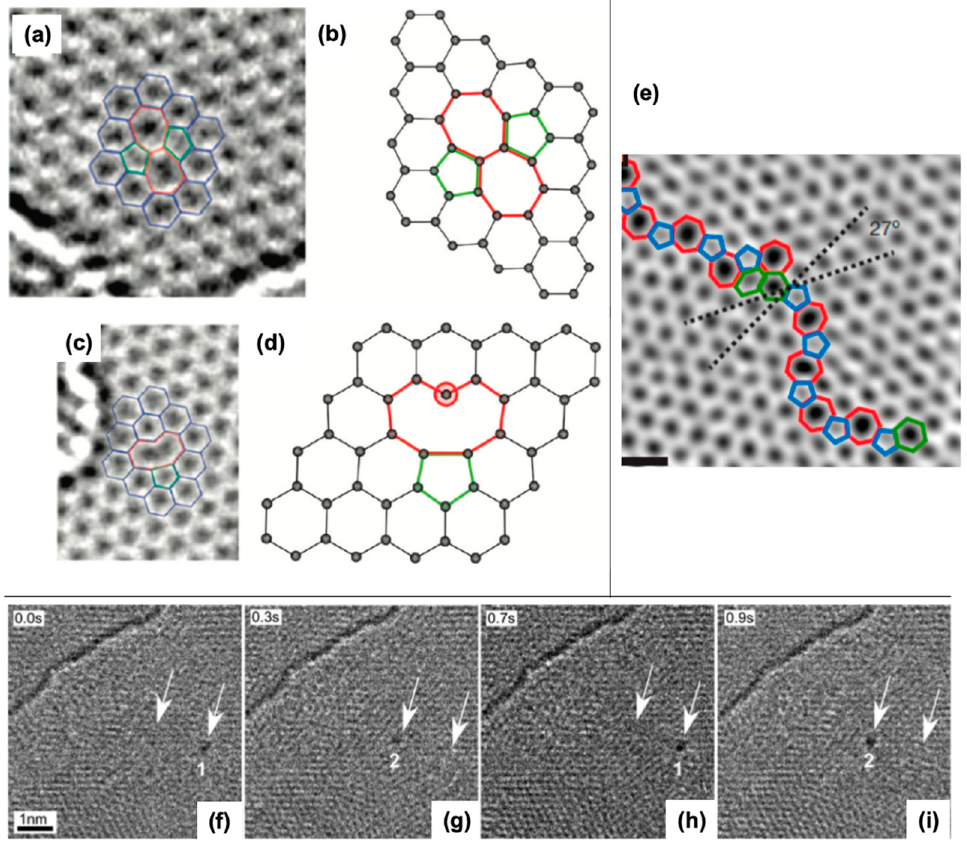
Figure 36. ( a , b ) illustrate the TEM a defect formed by rotating a carbon-carbon bond by 90° and its atomic structure as obtained from DFT calculations, respectively [211]. ( c , d ) show a single vacancy by experimental TEM and its atomic structure obtained by DFT calculation, respectively. ( e ) aberration-corrected annular dark-field STEM of line defects in graphene [216]; ( f – i ) jumping of foreign W atom (arrowed) on the surface of few-layer graphene eat 480 °C using in situ HRTEM, the repeating jumping between the trapping sites (1 and 2) at a distance of 1.5 nm shows the attraction between the metal adatom and the defect (reprinted with permission from [211]).